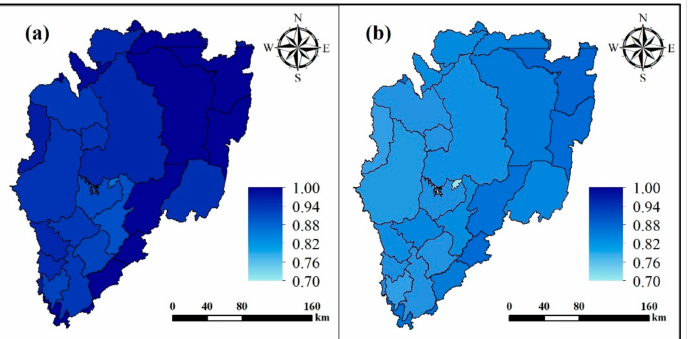
Figure 8. Grey relation grade maps of ( a ) climate change and ( b ) human influence for the AMD1